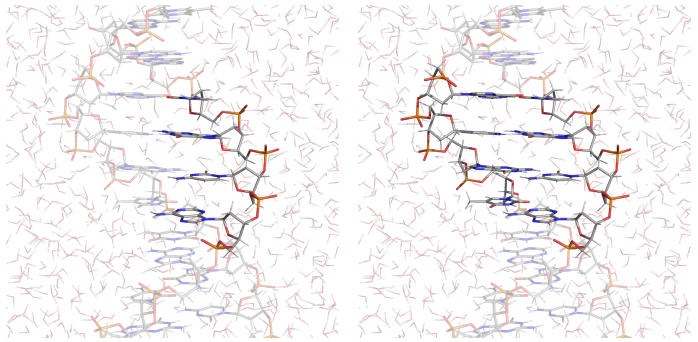
Figure 11. Representation of the solvated ds-(3 (cid:48) -TCGCGTTGCGCT-5 (cid:48) ) DNA double strand studied by Cauet et al. [158]. The highlighted atoms represent the two different QCs chosen in that work. Furthermore, the QM region was expanded to a few nucleobases (single- and double- stranded oligonucleotides d(5 (cid:48) -C8G9-3 (cid:48) ), d(5 (cid:48) -C8G9C10-3 (cid:48) ), and d(5 (cid:48) -A7C8G9C10-3 (cid:48) ))